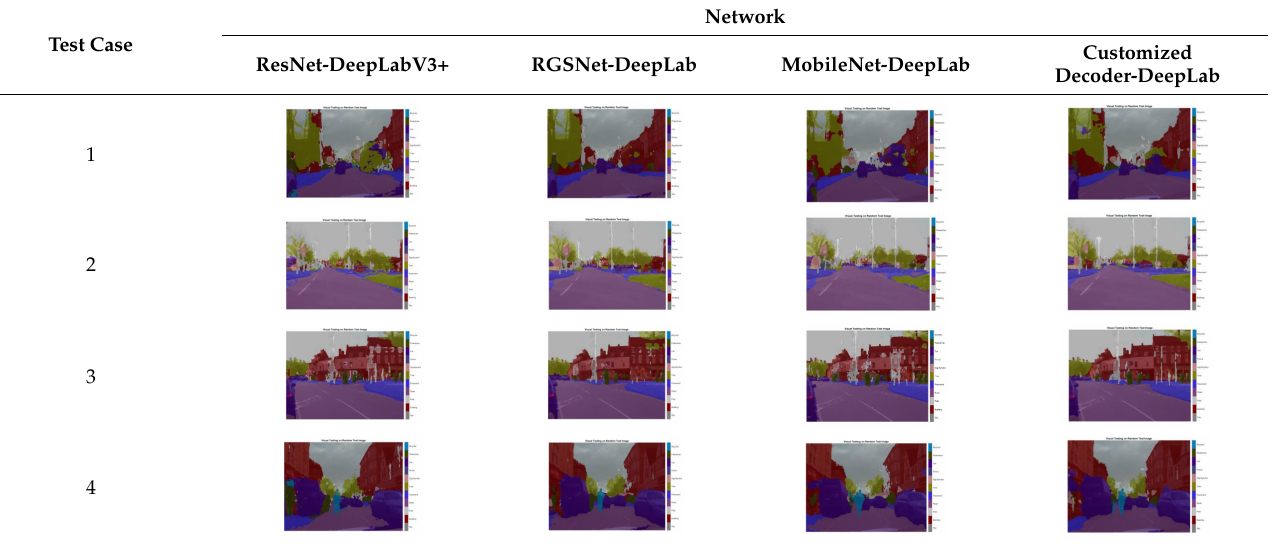
Table 7. Visual Semantic Segmentation Results.